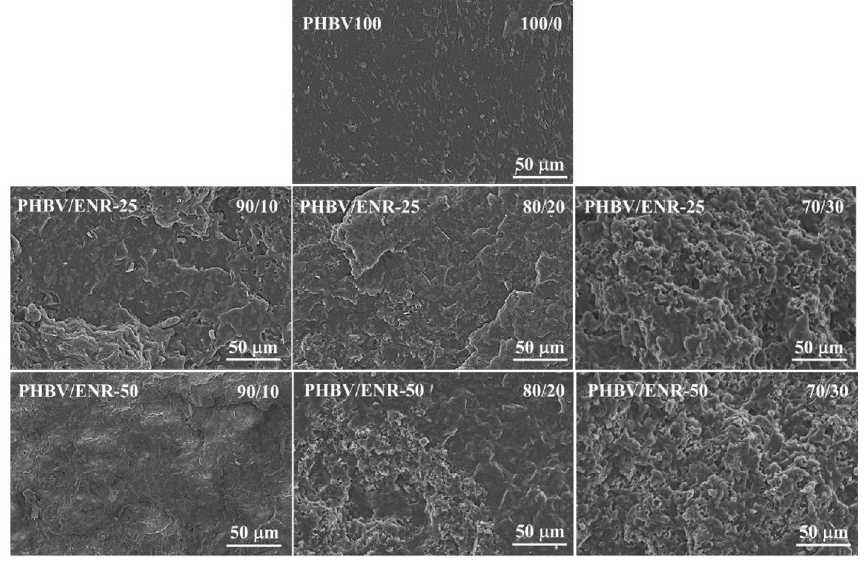
Figure 8. SEM micrographs of fractured surfaces of the neat PHBV, PHBV/ENR-25 blends, and PHBV/ENR-50 blends with the blending ratio of 90/10, 80/20, and